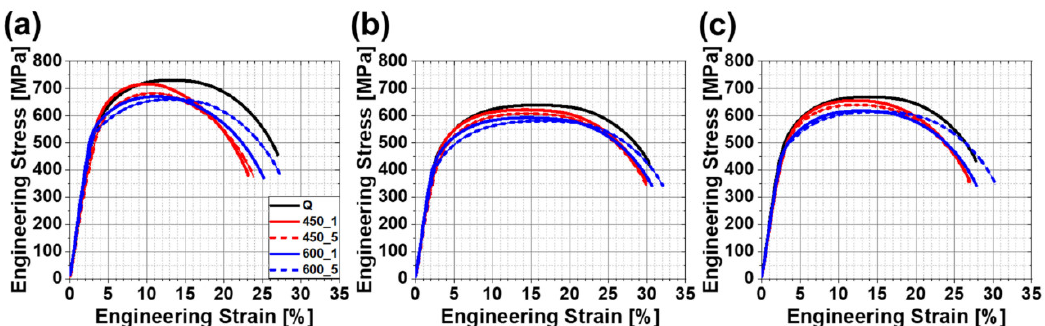
Figure 10. Engineering stress–strain curves of ( a ) FC (−10.6 °C/s), ( b ) MC (−4.6 °C/s), ( c ) SC (−2.5 °C/s) specimens according to the tempering conditions. Line colors and patterns distinguish tempering temperature: black is quenching, red is 450 °C and blue is 600 °C, respectively. Solid lines are 1 h, dotted lines are 5 h (excluded quenching).